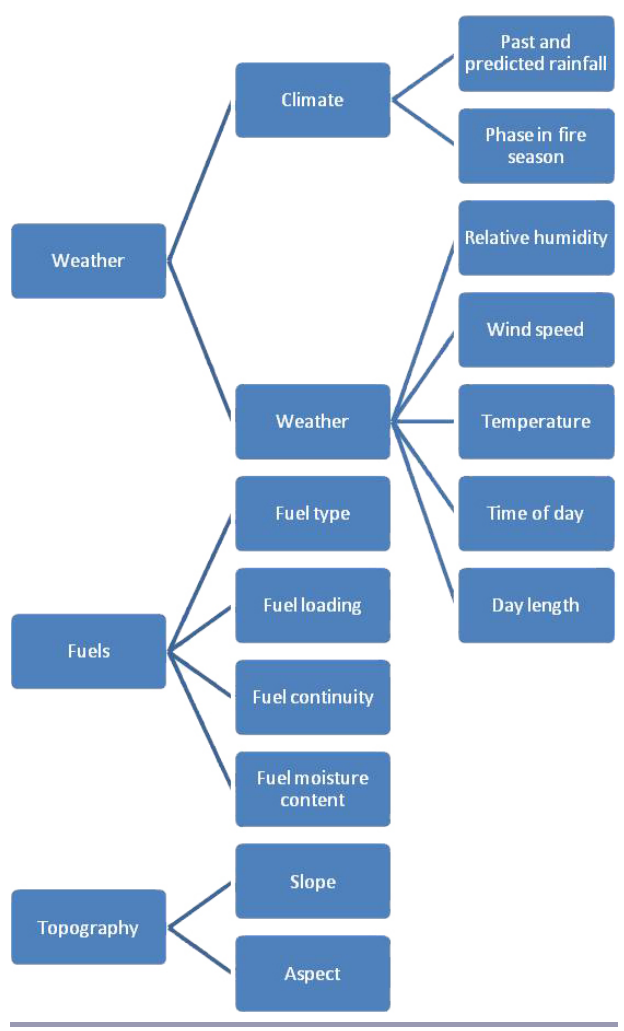
Table 2 . Objectives listed in the Koyukuk National Wildlife Refuge Fire Management Plan